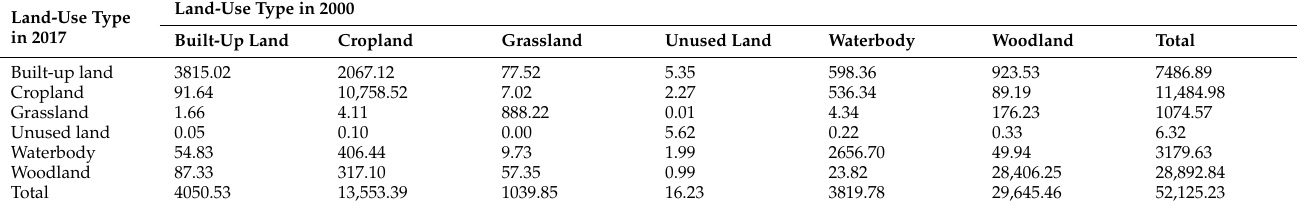
Table 3. Land-use transitions in the PRD between 2000 and 2017 (km 2 ).